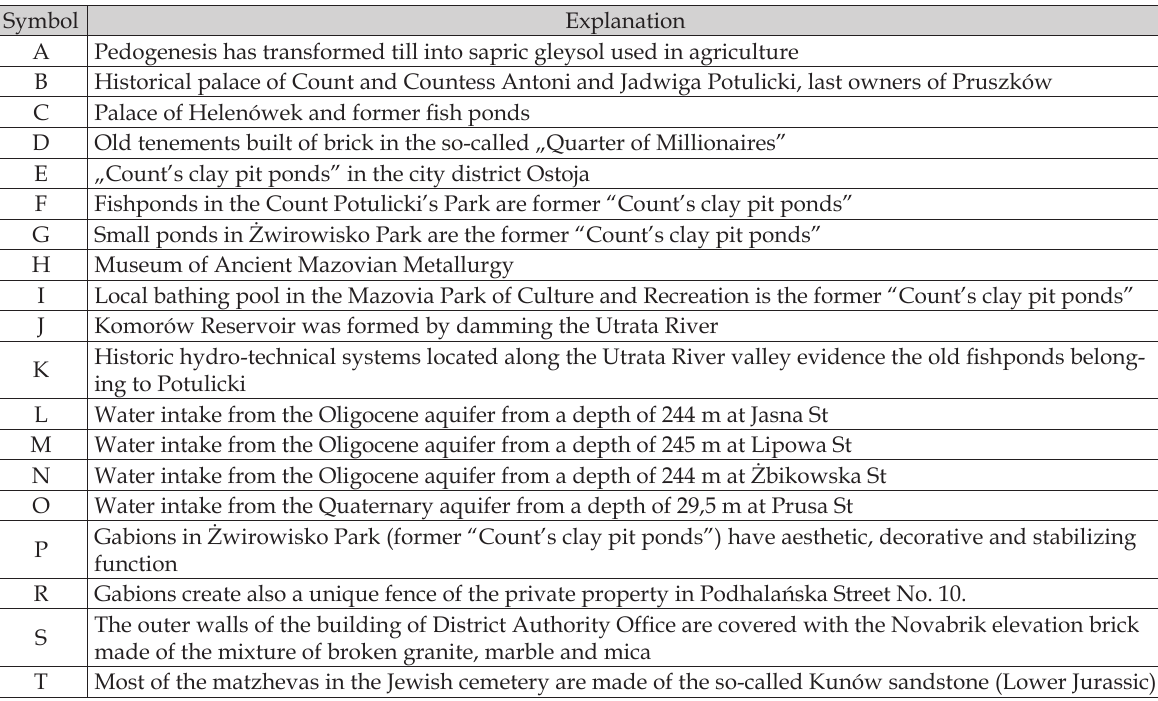
Table 1. Objects of abiotic heritage in Pruszków, present in different combination symbol Explanation